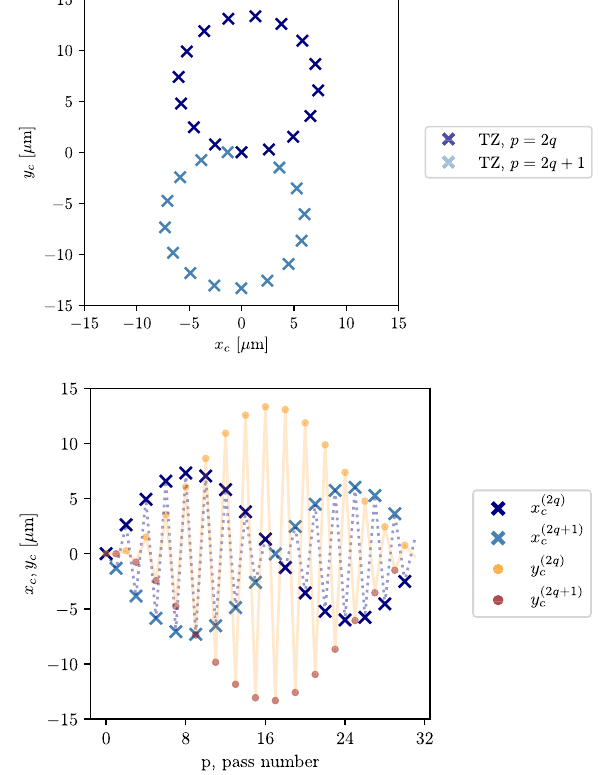
FIG. 24. Simulation of the effect of a 10 μ m solely TZ translation misalignment of M2 on the circulation trace at the IP, where p is the path number and q ∈ ½ 0 ; 16 (cid:4)